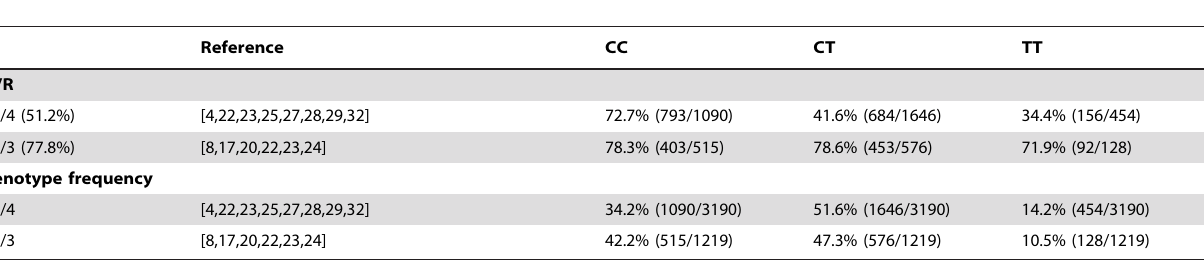
Table 2. SVR rates and frequency for rs12979860 genotypes in Caucasian treatment-naı¨ve patients with complete